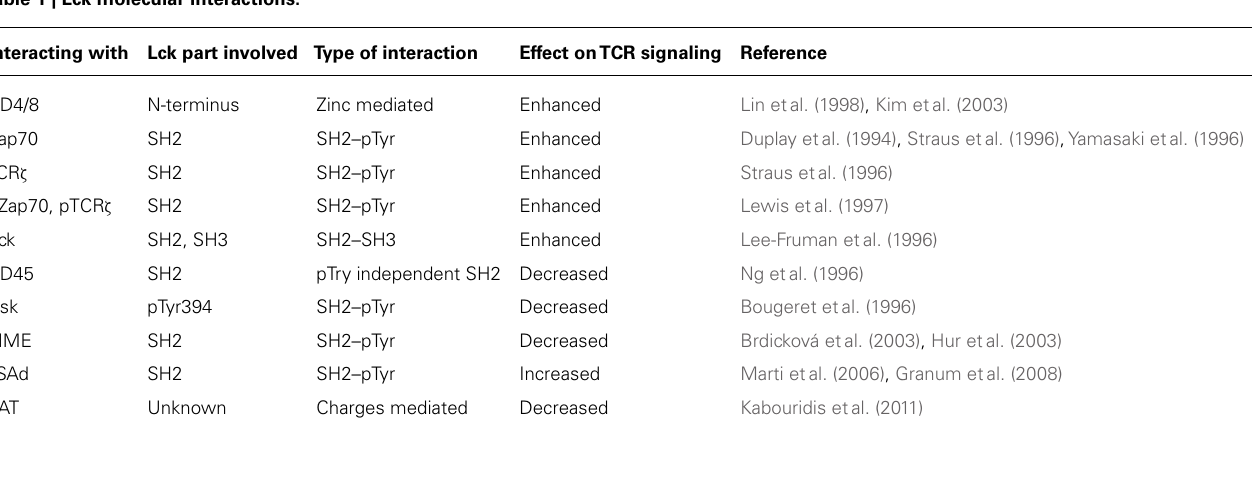
Table 1 | Lck molecular